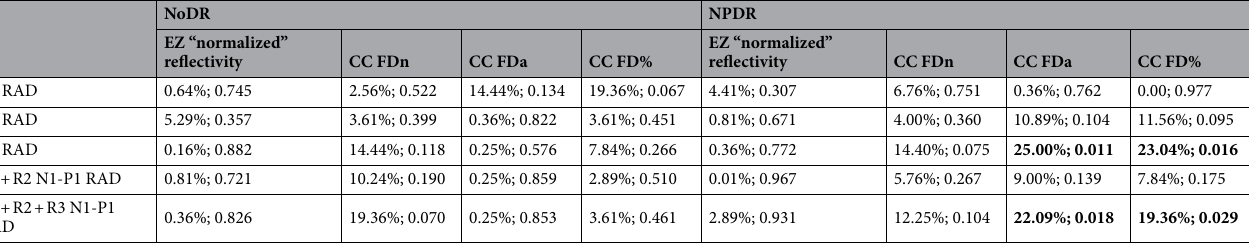
Table 4. Pearson’s linear correlations (R 2 ;p) between optical coherence tomography angiography (OCTA) and multifocal electroretinogram N1-P1 response amplitude density (RAD) values in diabetic patients without diabetic retinopathy (NoDR) and with mild signs of diabetic retinopathy (NPDR). R1 = ring 1, 0°–2.5° foveal eccentricity; R2 = ring 2, 2.5°–5° foveal eccentricity; R3 = ring 3, 5°–10° foveal eccentricity; R1 + R2 = area covering 0–5° foveal eccentricity; R1 + R2 + R3 = area covering 0°–10° foveal eccentricity; EZ = ellipsoid